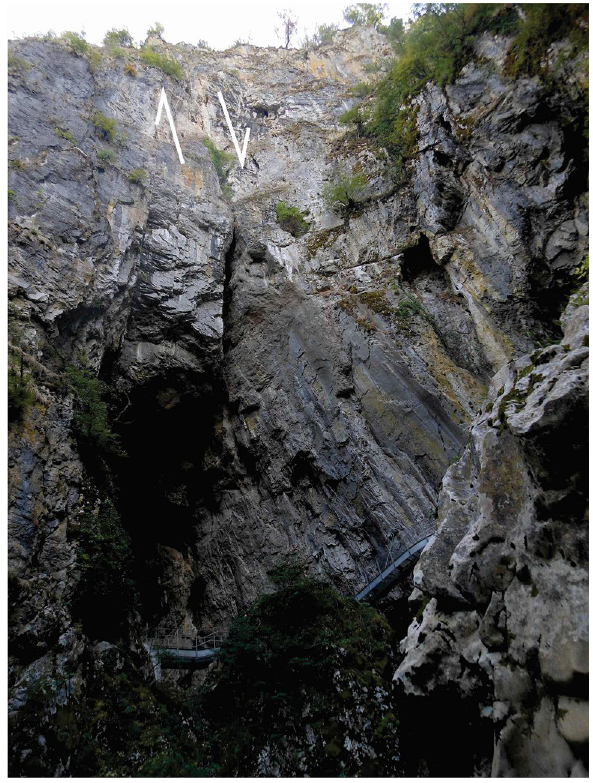
Fig. 4 Mala Dolina: an almost vertical fault with structural ele- ments (dip direction/dip angle) 170/85 is traced from the surface to Mariničeva Jama. Photo S. Šebela